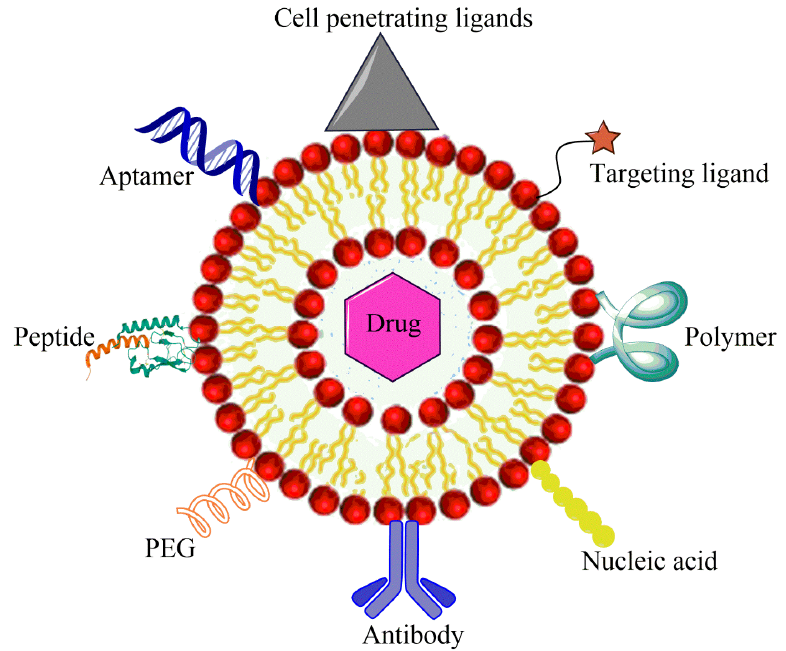
Figure 5. Ligand anchored nanocarrier and its interaction with OSA cell.